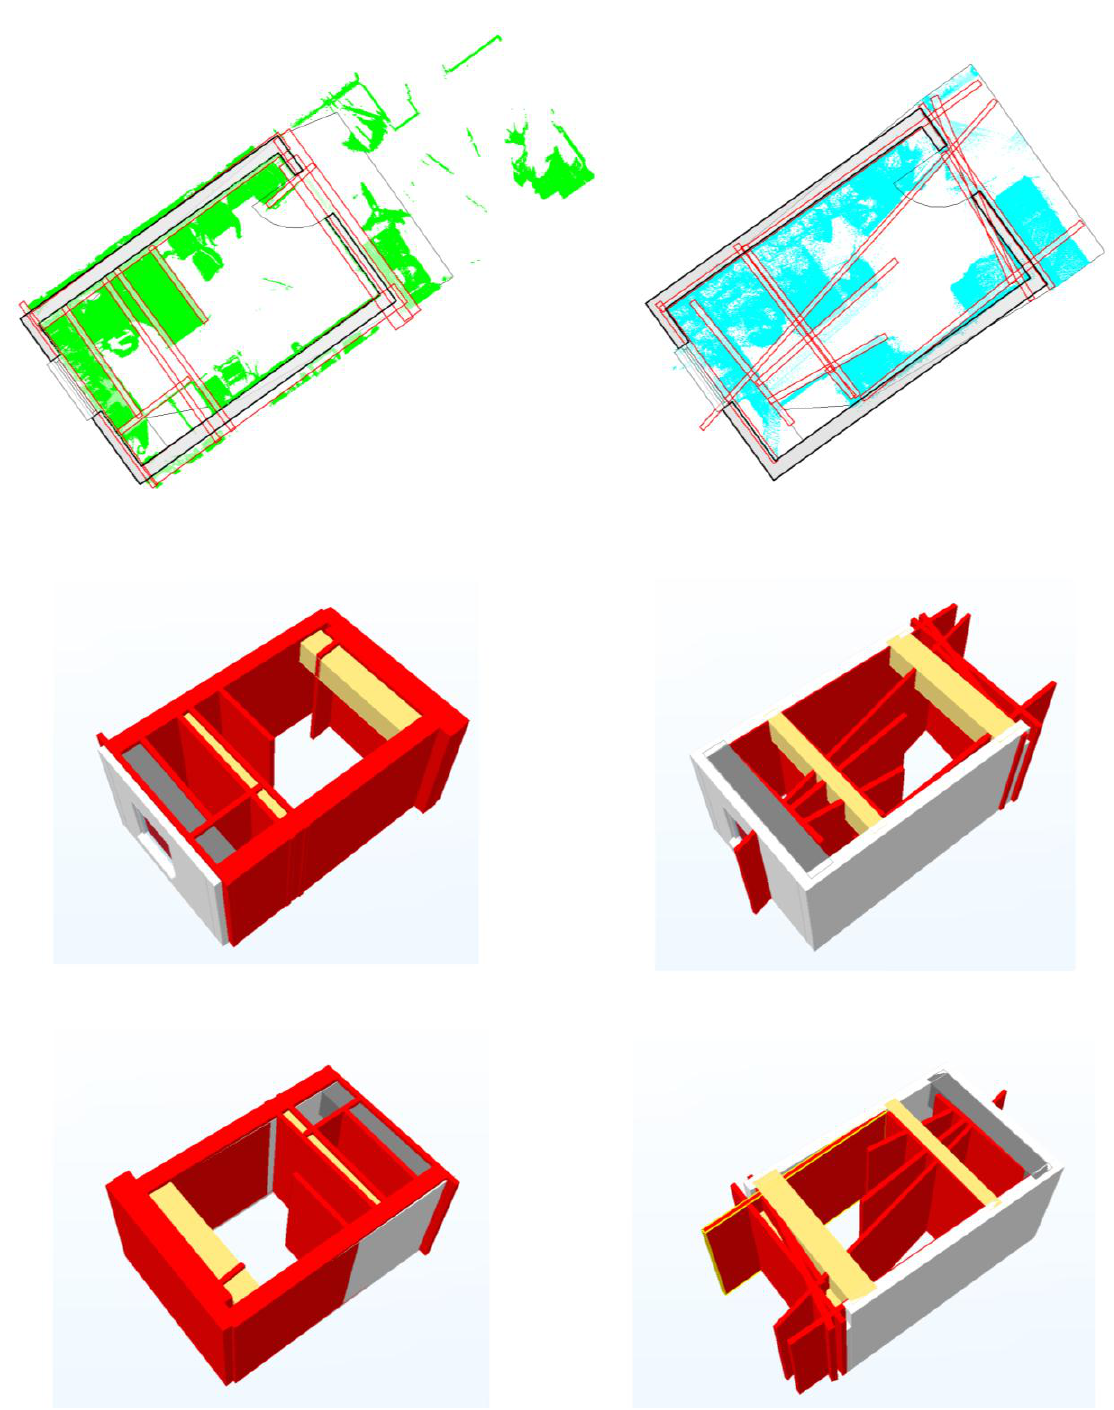
Figure 11. Extracted walls (red) of the office from the static (green) and mobile (blue) point cloud data overlaid on the human-generated model